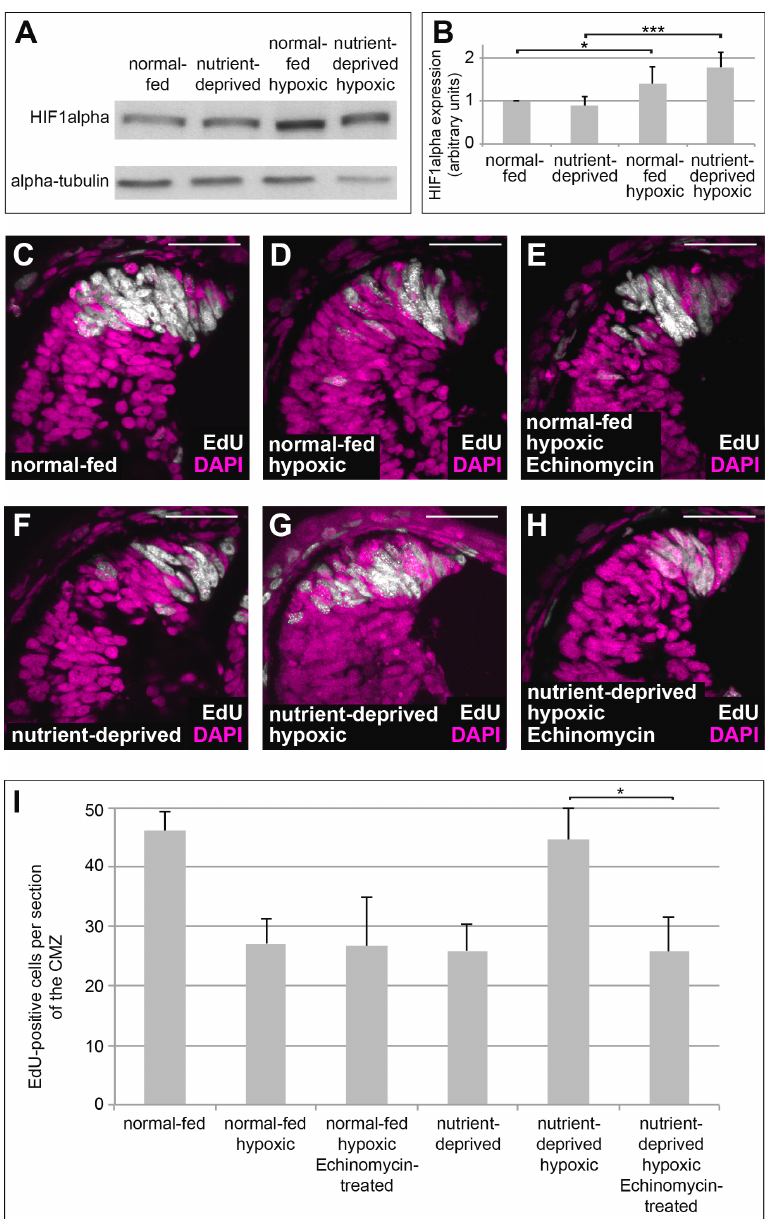
Figure 2. HIF-1 activity is required to induce re-initiation of proliferation in nutrient-deprived hypoxic retinas. ( A ) Western blot of retinas isolated from normal-fed or nutrient-deprived animals kept under normal oxygen concentrations or in hypoxia, probed for HIF-1 α subunit and α -tubulin. HIF-1 α is stabilized under hypoxia in both normal-fed and nutrient-deprived animals. At least 22 retinas were taken for each condition; all conditions in each experiment have the same number of retinas ( n = 5). ( B ) Quantification of the Western blot performed in ( A ). Error bars represent standard deviations. Two hooked ends of horizontal lines indicate the two conditions compared, * p -value < 0.05, *** p -value < 0.001; n = 5. ( C – H ) EdU incorporation in DAPI-stained retinas from normal-fed animals ( C – E ) kept in normoxia ( C ), hypoxia ( D ) or incubated with Echinomycin under hypoxia ( E ) and in nutrient-deprived animals kept in normoxia ( F ), hypoxia ( G ) or incubated with Echinomycin under hypoxia ( H ). Nutrient-deprived retinas no longer resume their proliferation in hypoxia when function of HIF-1 is blocked by Echinomycin. Scale bars = 50 µm. In each condition, a minimum of 10 retinas was examined. ( I ) Quantification of the experiment performed in ( C – H ). Error bars represent standard deviations between three independent experiments. Two hooked ends of horizontal lines indicate the two conditions compared, * p -value < 0.05; n > 3. For each condition, between 10 and 15 retinas were quantified.